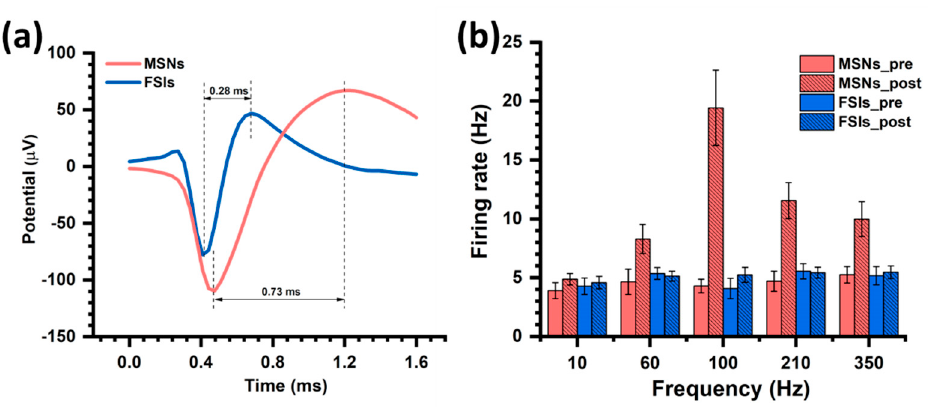
Figure 7. ResponseofMSNsandFSIsduringDBS.( a )ThemeanwaveformofMSNsandFSIs. ( b )Themean Figure 7. Response of MSNs and FSIs during DBS. ( a ) The mean waveform of MSNs and FSIs. ( b ) The firing rate variations of MSNs and FSIs before and after mean firing rate variations of MSNs and FSIs before and after DBS.